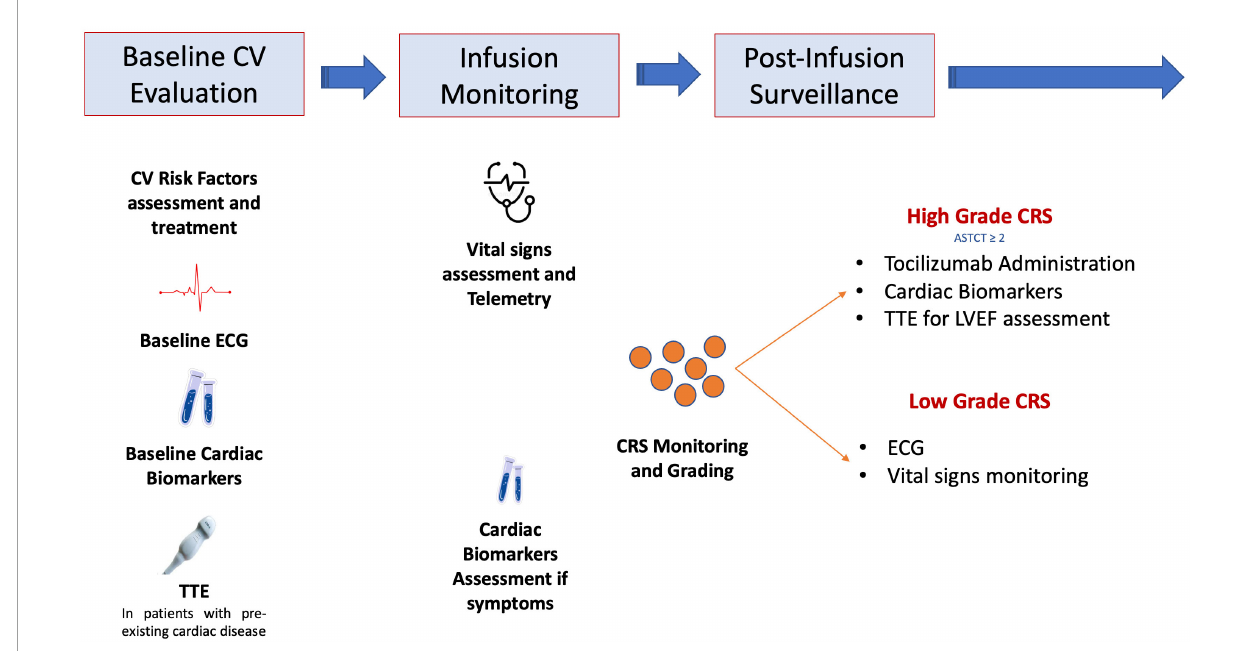
FIGURE1 Proposed diagnostic work-up and management strategy in patients undergoing chimeric antigen receptor (CAR)-T cell treatment and with suspected cardiovascular toxicity. ASTCT, American Society for Transplantation and Cellular Therapy; CRS, cytokine release syndrome; CV, cardiovascular; ECG, electrocardiogram; TTE, transthoracic